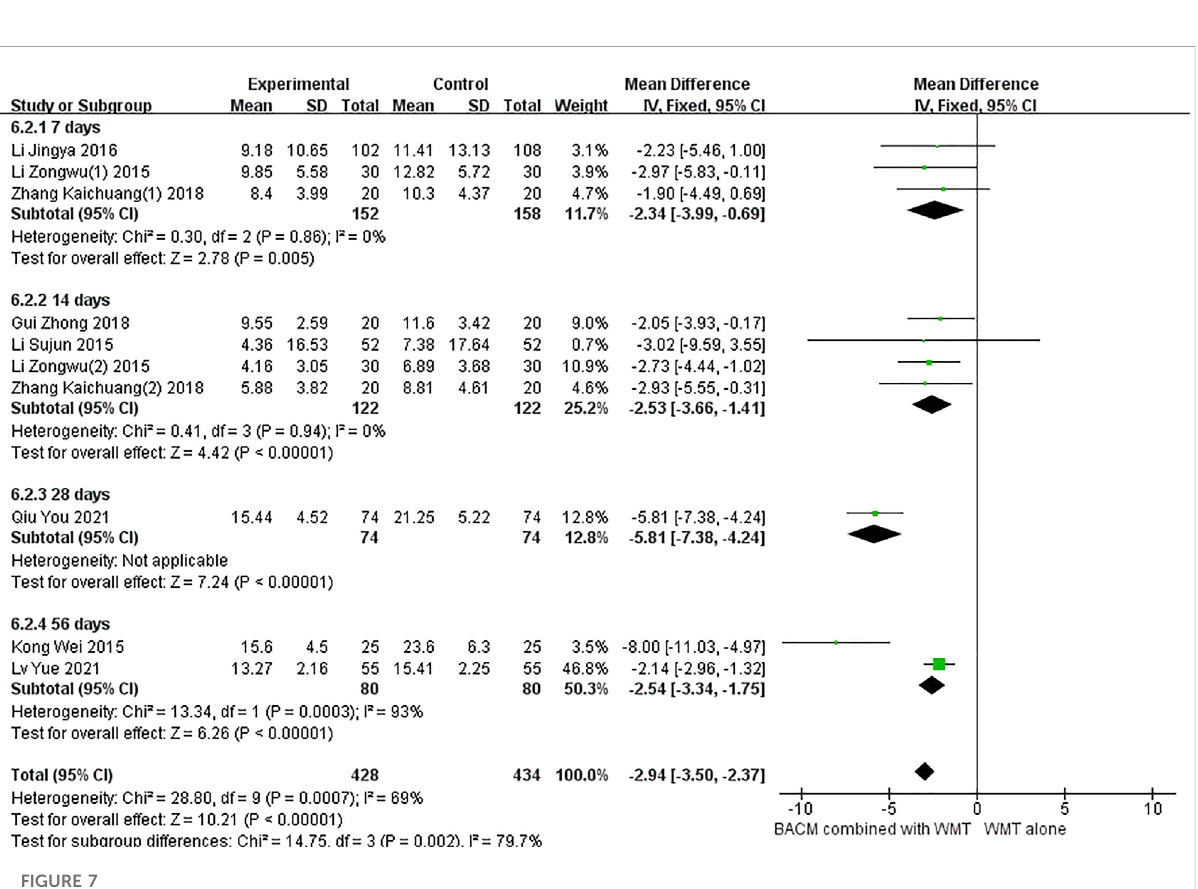
FIGURE 7 The forest plot of the volume of cerebral hematoma by BACM for